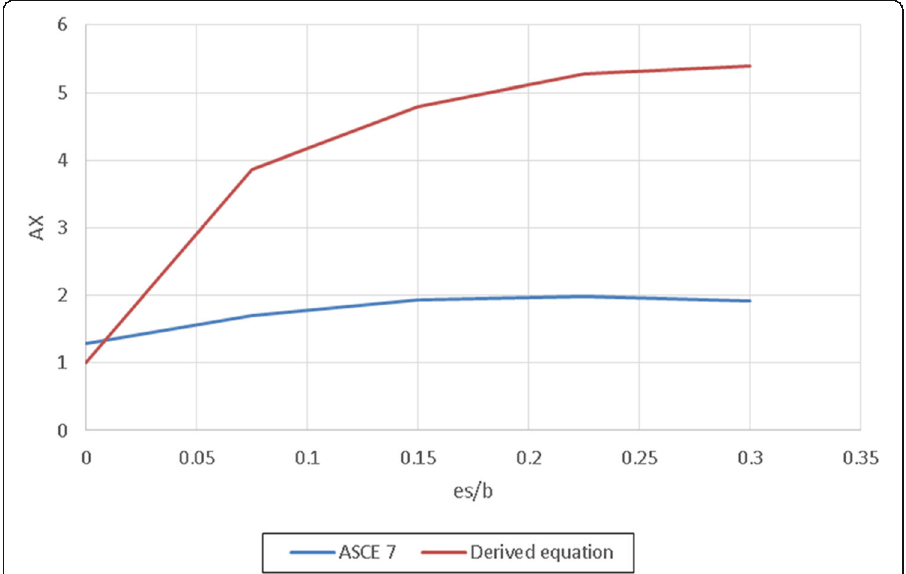
Fig. 44 Comparison of eccentricity ratio — max. A x for ASCE 7-10 and derived